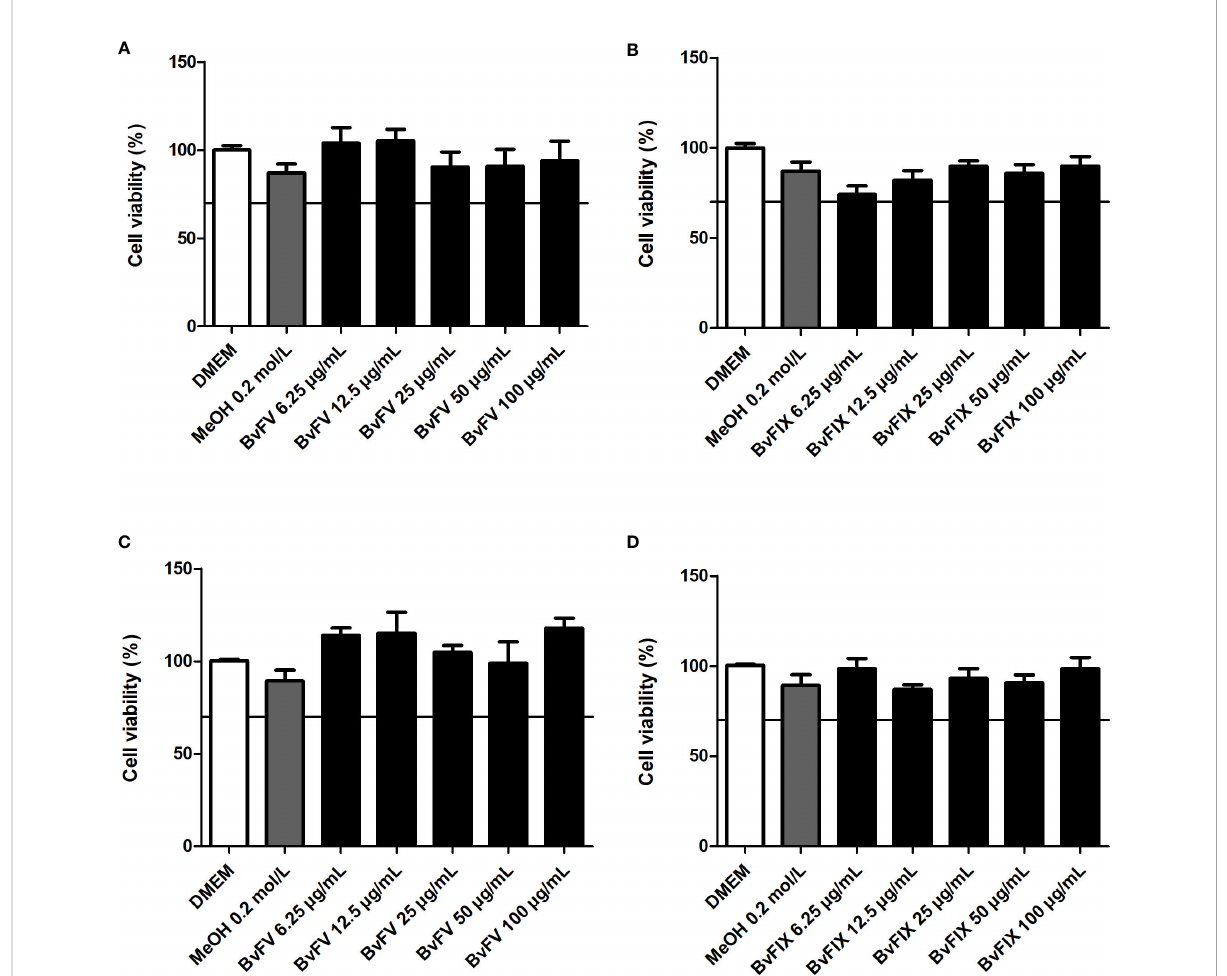
FIGURE 3 Evaluation of cytotoxicity of the fungal extracts. Human dermal fi broblasts were treated for 48 h with different concentrations of fungal extracts or with the solvent used to solubilize the samples (MeOH), (A) BvFV, and (B) BvFIX. HeLa cells were treated for 24 h with different concentrations of fungal extracts or with the solvent used to solubilize the samples (MeOH), (C) BvFV, and (D) BvFIX. The results presented represent mean ± S.E.M. in the percentage of viable